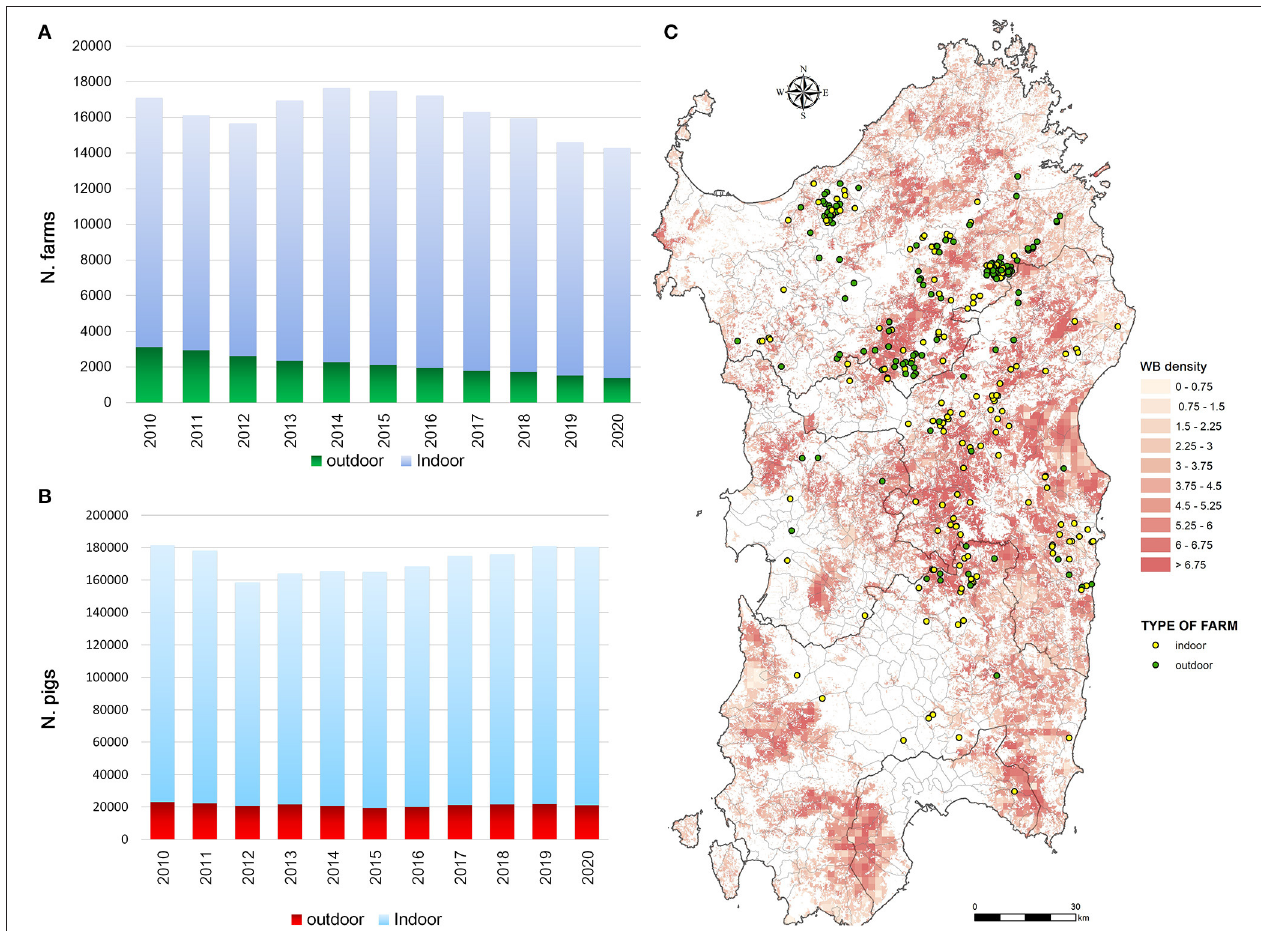
FIGURE 1 | Sardinian epidemiological context. (A) Total number of farms in Sardinia and (B) the number of domestic pigs bred in domestic pig farms by years, from 2010 to 2020. Data are collected by the Italian National Database and correspond to the annual animal census (30th June). (C) Outbreaks occurred in indoor and outdoor domestic pig farms from 2010 to 2018 over the wild boar density by